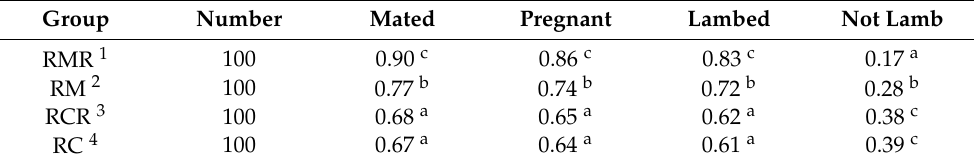
Table 2. Proportion of mated ewes, pregnant ewes, lambed ewes, and ewes that did not lamb in the four groups. The results were analyzed by Chi-square